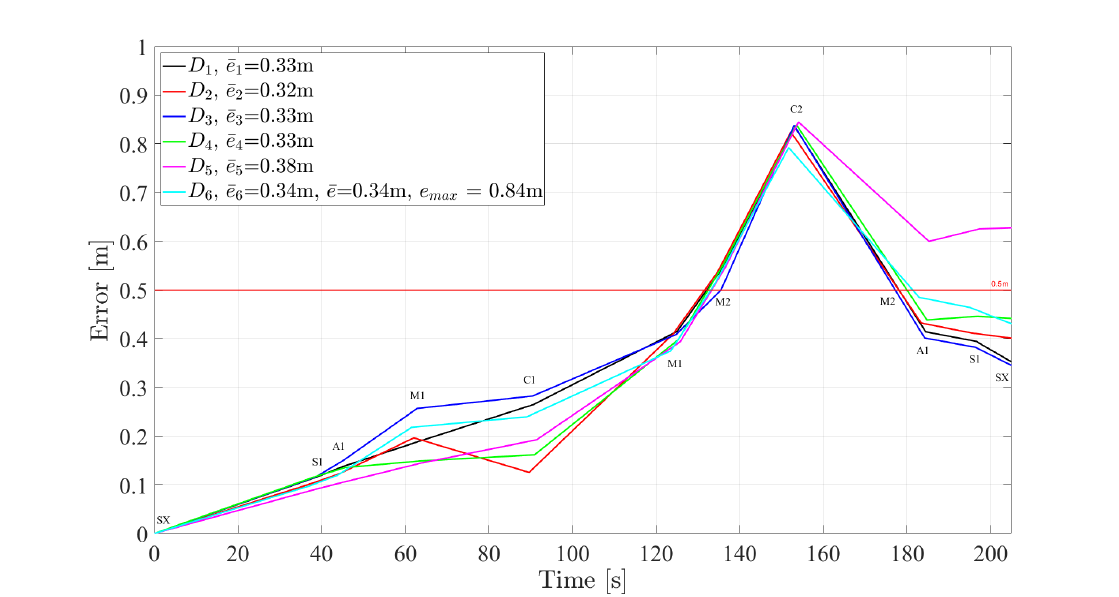
Figure 4. Error performance of partly successive FeetSLAM for one walk with 6 sensors mounted on the foot. The window size was 3 and the number of iteration was 3. The results are always below one meter and the average result over all six data sets was 0.34 m.